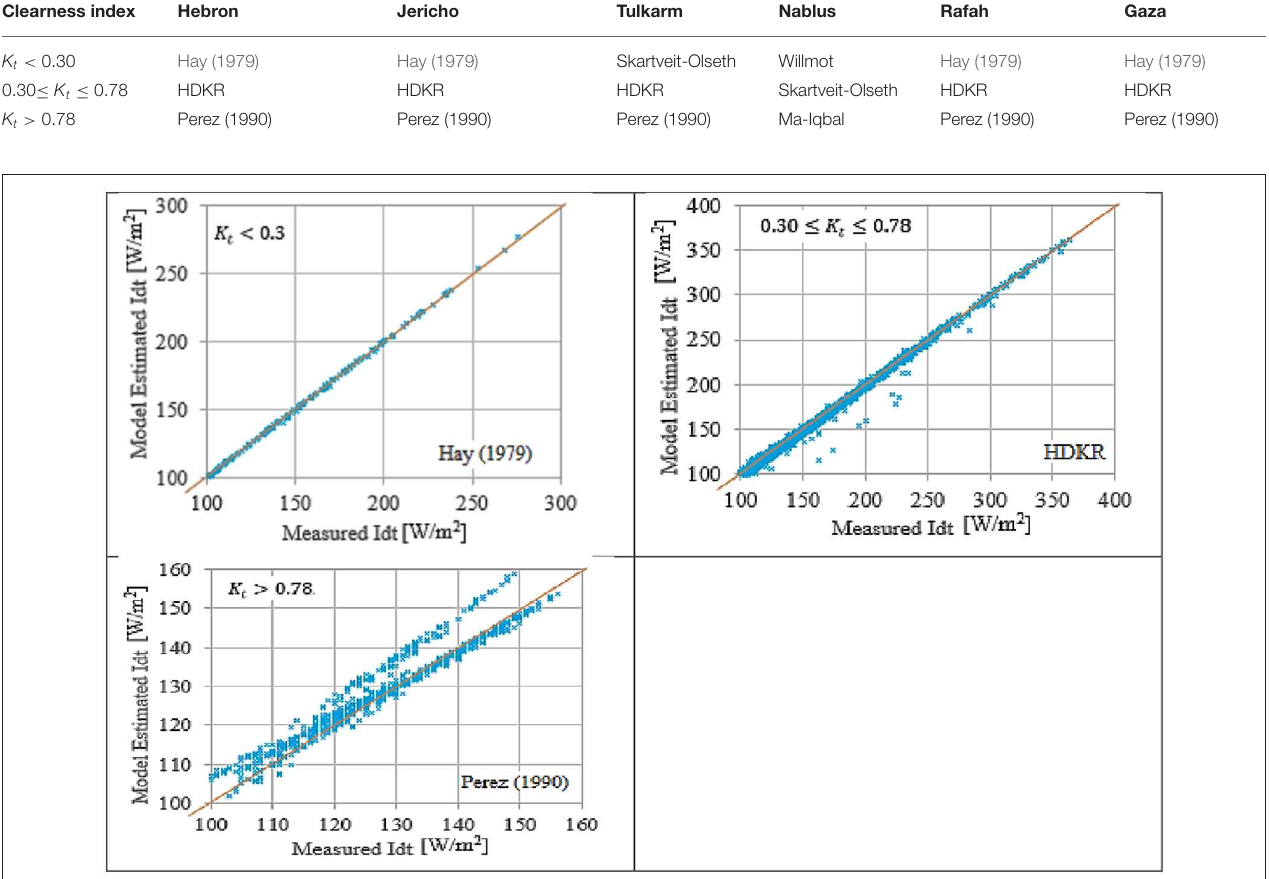
FIGURE 5 | Preferred transposition model for different sky conditions for Hebron city (8,700 points depicted in the graph) (blue dot), y = x relation (red line).